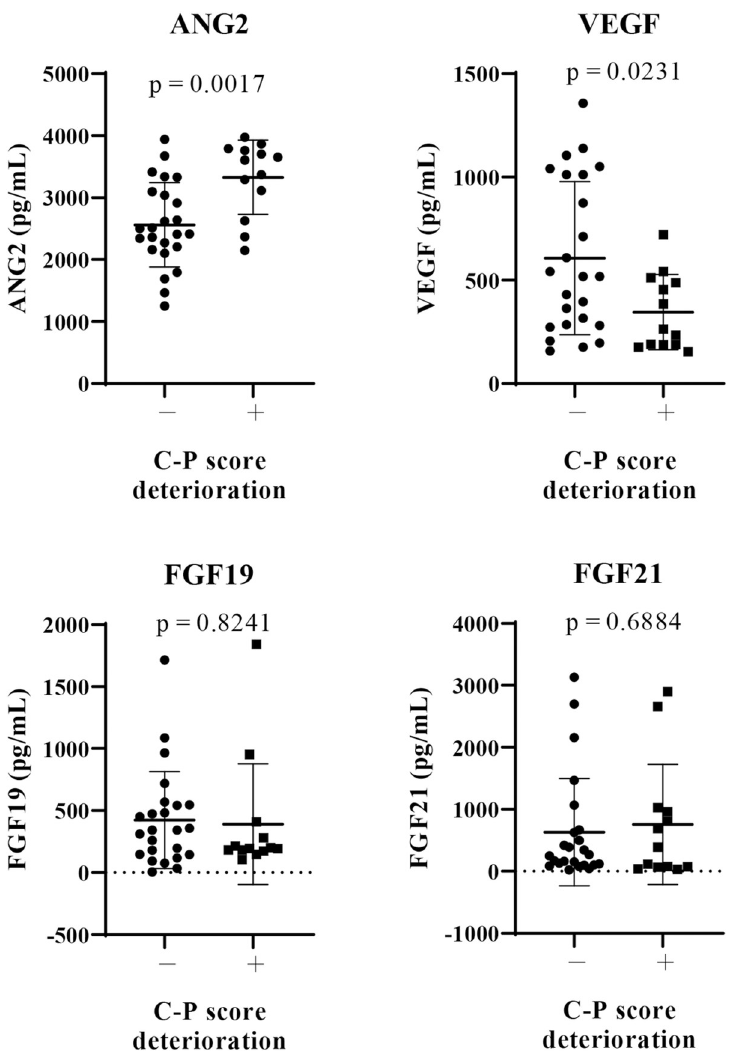
Fig 1. Comparison of baseline serum growth factors between patients with and without a deterioration of Child- Pugh score at 8 weeks after lenvatinib initiation. Baseline serum levels of FGF19, FGF21, ANG2, and VEGF were evaluated in all patients. We compared the mean values between patients with and those without deterioration of Child-Pugh (C-P) score at 8 weeks after lenvatinib initiation. P < 0.05 was considered statistically significant. FGF, fibroblast growth factor, ANG2: angiopoietin 2, VEGF: vascular endothelial growth factor.